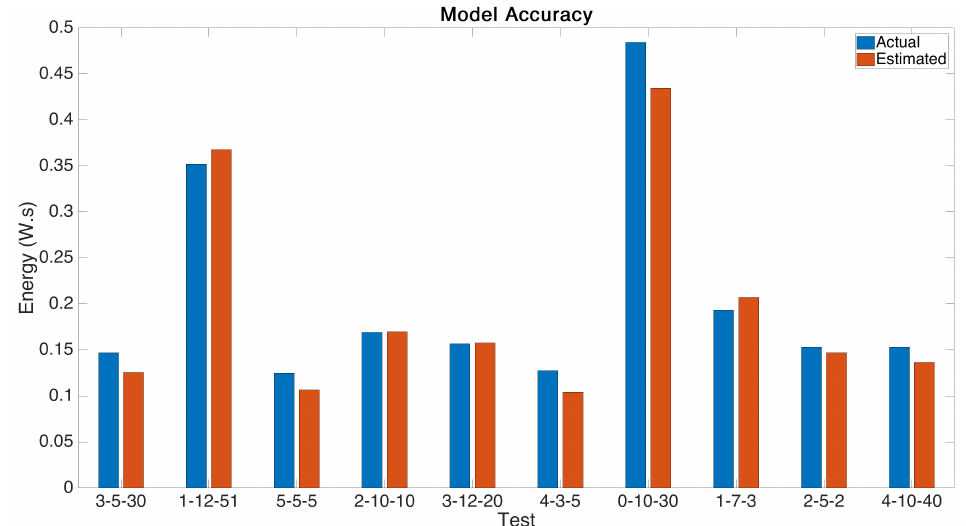
Figure 8. Model verification, comparing actual, measured experimental energy with that predicted by the